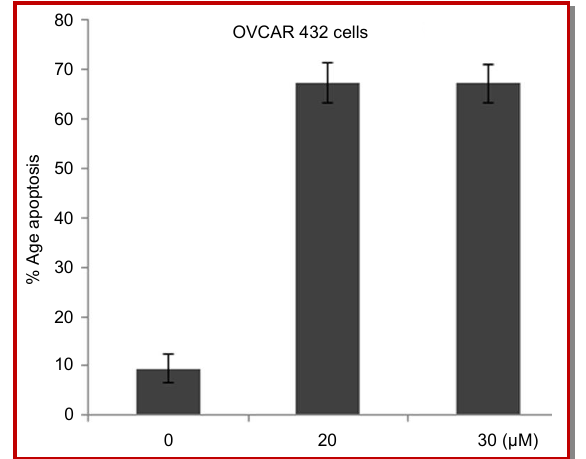
Figure 3: Rate of apoptosis in OVCAR 432 cells using quantita- tive fluorescence microscopy. All the results are mean of tripli- cate measurements